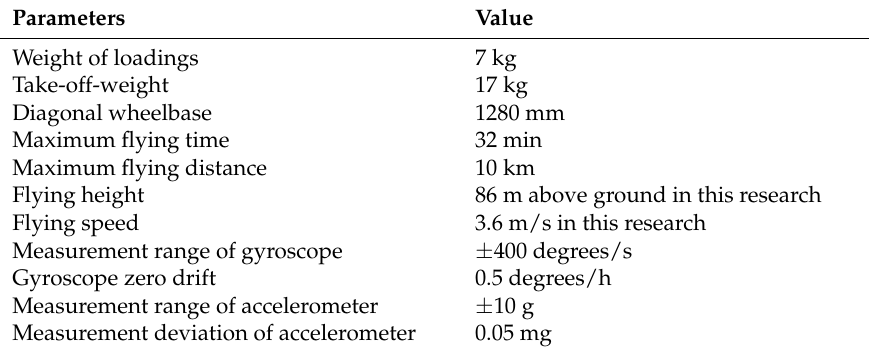
Table 1. Specifications of the UAV platform.